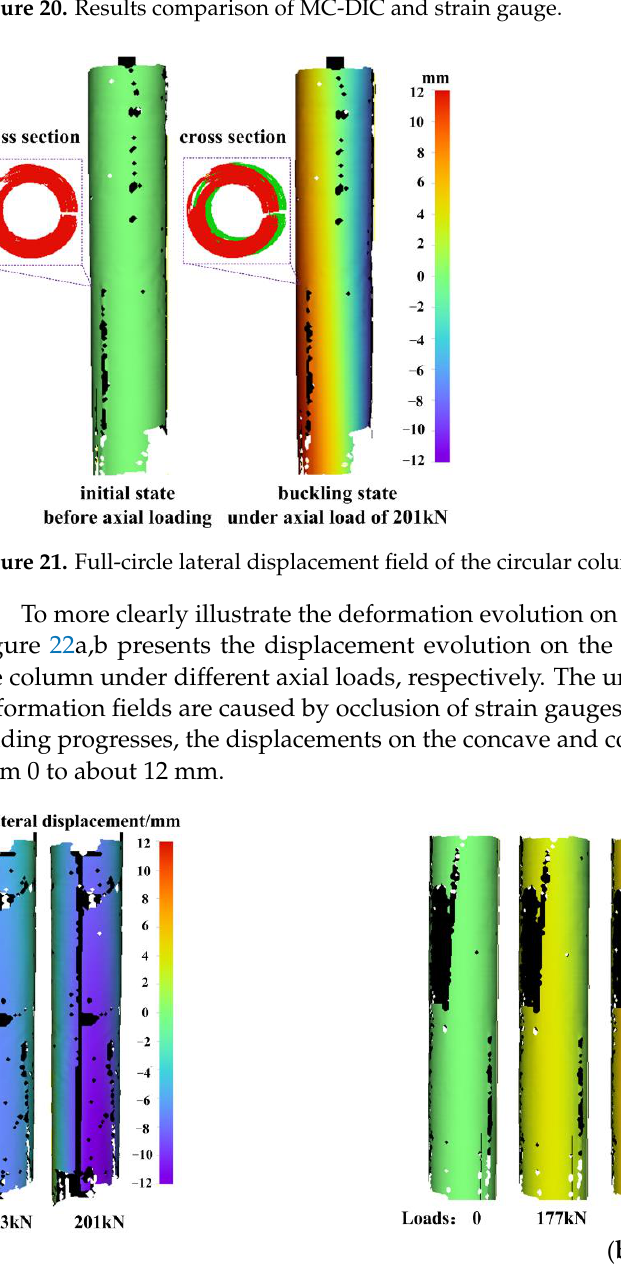
Figure 20. Results comparison of MC-DIC and strain gauge.